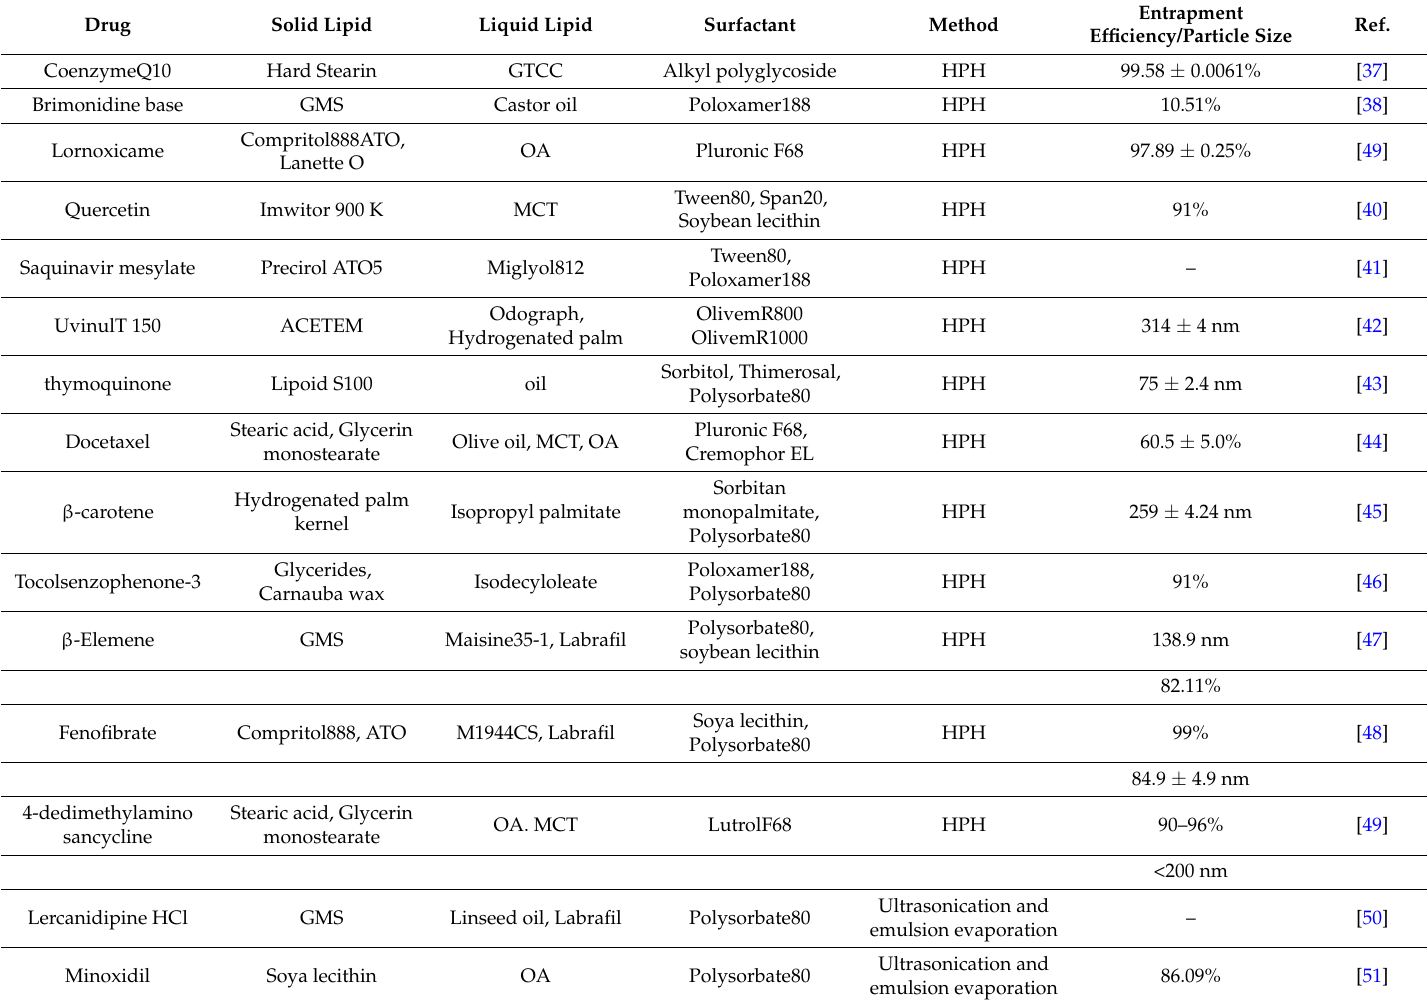
Table 1. Summary of methods used to prepare